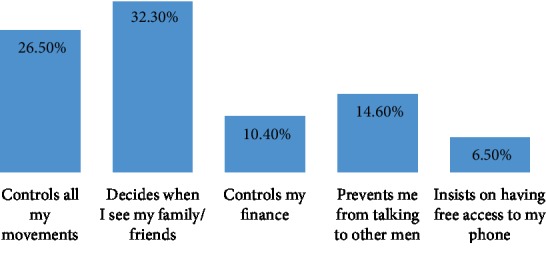
Controlling behavior of partner (multiple responses considered).